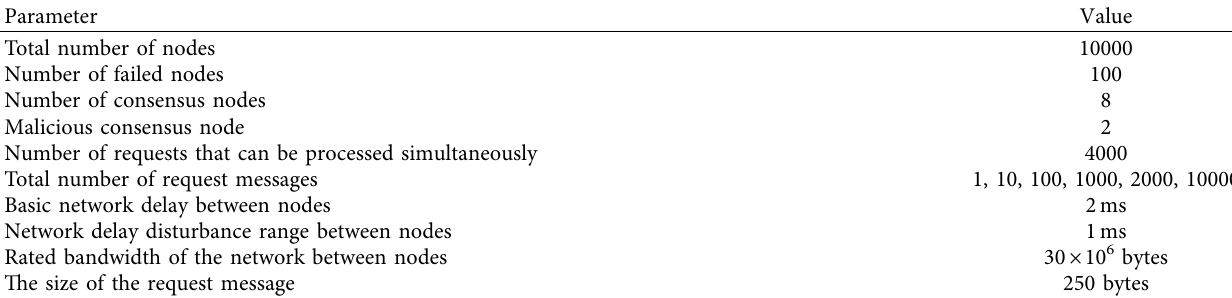
Table 2: Simulation parameter table for evaluating algorithm throughput and delay.